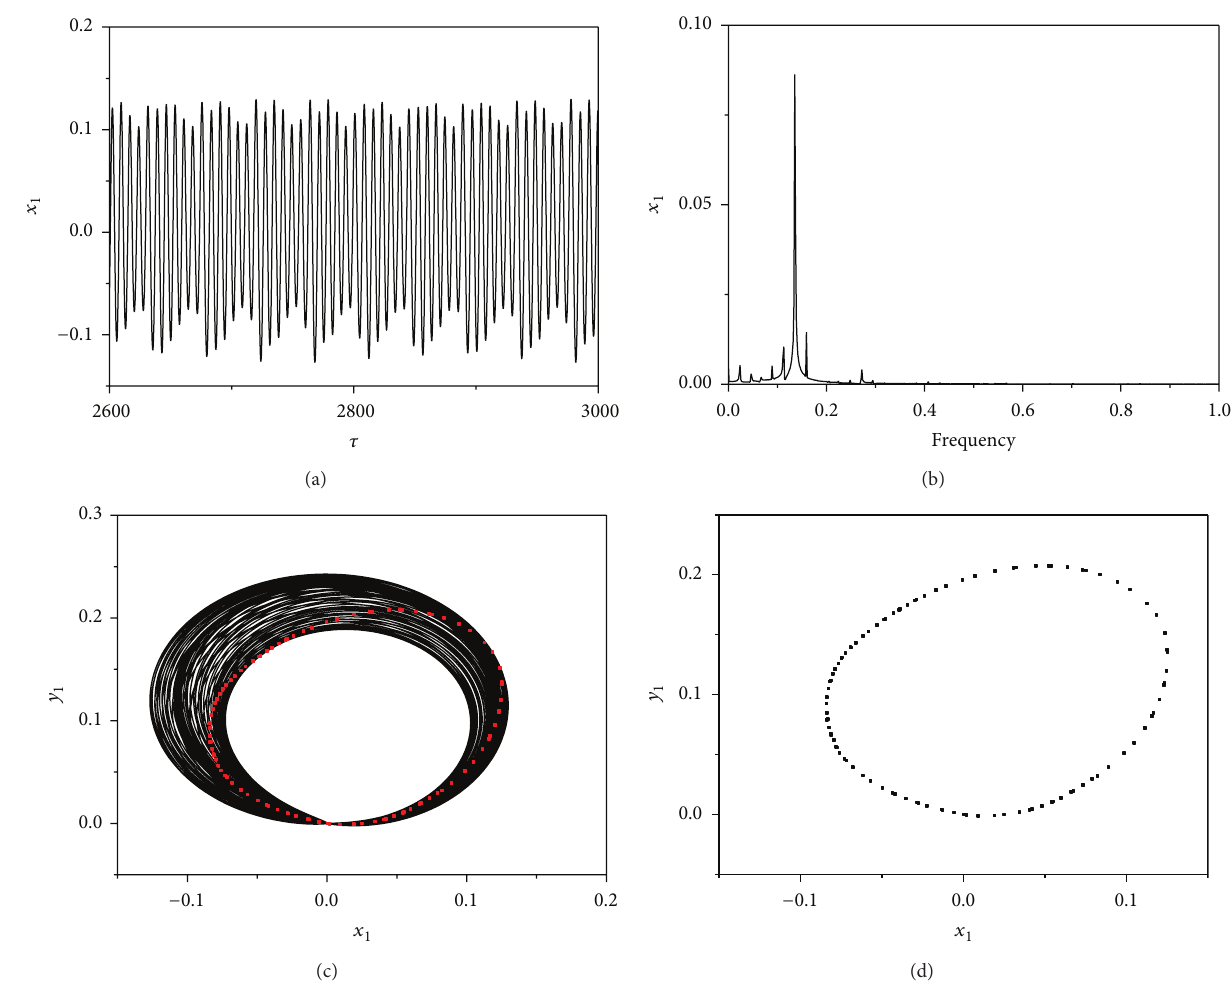
Figure 7: See 𝜔 = 0.95 . (a) Displacement response. (b) Frequency spectrum. (c) Rotor orbit. (d) Poincar´e